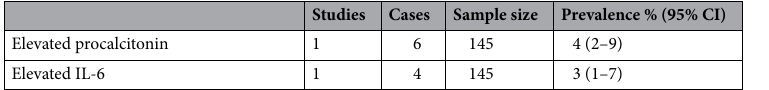
Table 2. Long-term effects in PASC patients. Random effects weighted by quality effects model MetaXL for 2 or more studiesC-reactive protein (CRP), Interleukin-6 (IL-6), D-dimer, NT-proBNP, serum ferritin, N-terminal (NT)-pro hormone BNP